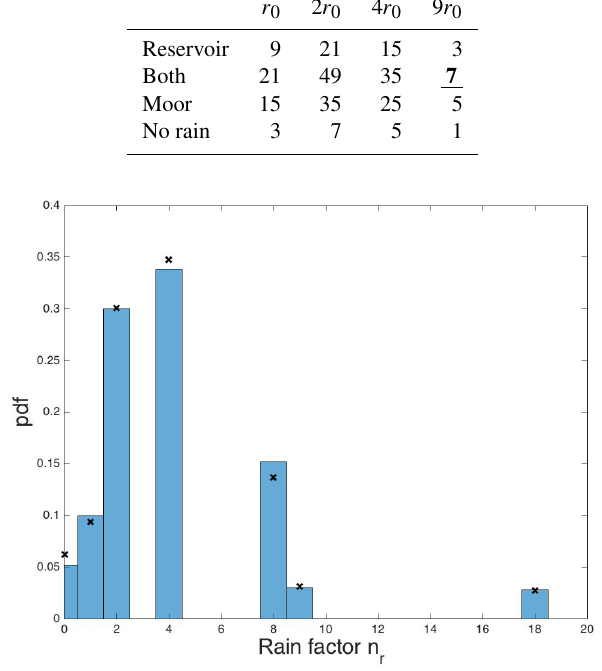
Figure 3. The pdf of random rainfall outcomes over 500wd’s, dis- played as a scaled histogram, is compared with the theoretical dis- crete pdf (Eq. 1), denoted by the black crosses. Extreme cases with 18 r 0 rainfall are observed in moor and reservoir combined, here in this 500wd trial with an occurrence on the